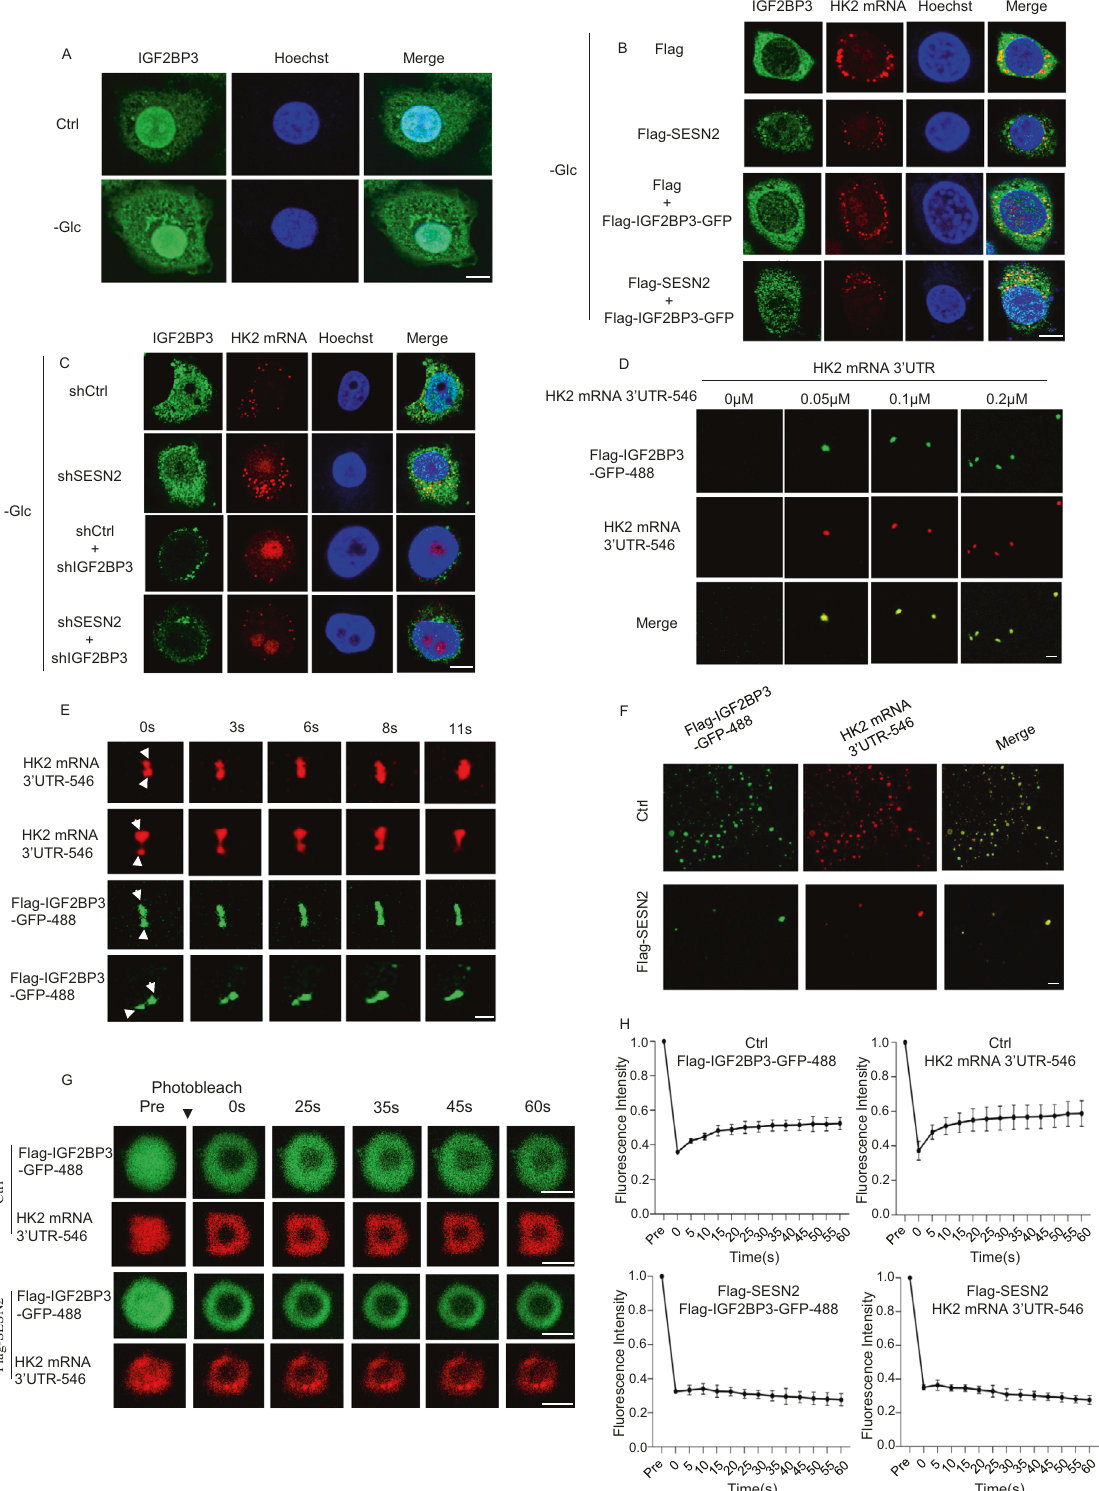
RNA interference and transfections Gene knockdown experiments were conducted by lentiviral-mediated transduction with short hairpin RNAs (shRNAs). Lentiviral particles were generated by transfection of 293 T cells with PLKO.1 vectors containing speci fi c shRNAs (Table S1) along with pREV, pGag, pVSVG at the ratio of 2:2:2:1 in Opti-MEM medium (Thermo Fisher#31985062) for